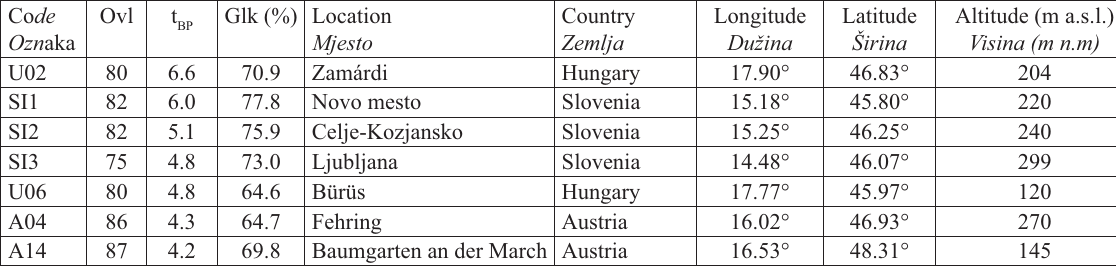
Table 2 Crossdating parameters for comparison of the residual chronology of oak from Kobiljak near Zagreb, Croatia (HR1) with local residual oak chronologies from Austria (A*), Hungary (U*), Slovenia (SI*); for the locations, compare Fig. 5 (parameters: overlapping – Ovl, coeffi cient of agreement – Glk% and t-value – t ) BP Tablica 2 . Parametri za usporedbu rezidualne kronologije hrasta iz Kobiljaka pokraj Zagreba, Hrvatska (HR1) s lokalnim rezidualnim kronologijama hrasta iz Austrije (A*), Mađarske (U*), Slovenije (SI*); lokacije usporediti sa slikom 5. (Ovl – preklapanje, Glk – koefi cijent slaganja, t – t vrijednost) BP Comparison with oak chronology HR1, period 1922-2008, Longitude16º09’ E, Latitude 45º49’ N, Altitude 140 m a.s.l. Usporedba sa kronologijom hrasta HR1, razdoblje 1922. - 2008., zemljopisna dužina 16º09 E, zemljopisna širina 45º49’ N, visina 140 m